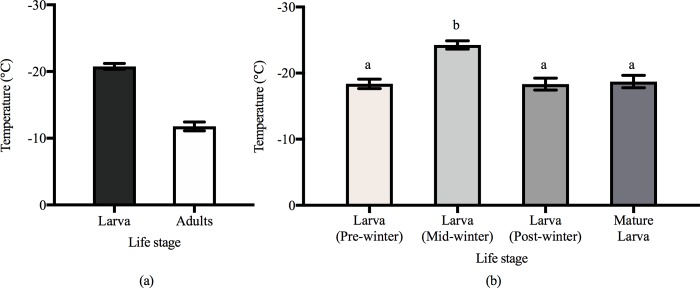
SCP (mean ± SEM) for different life stages of S. noctilio.(a) The SCP of all larval samples and adults. (b) The SCP of larvae that collecting from different periods, pre-winter means Oct. 2017 to Nov.2017, min-winter means Dec. 2017 to Jan. 2018, post-winter means Feb. 2018 to Mar. 2018 and late-stage larvae were collected during May. 2017 to Jun. 2017. The alphabet means that there is a difference P < 0.01 in Fisher's LSD test.